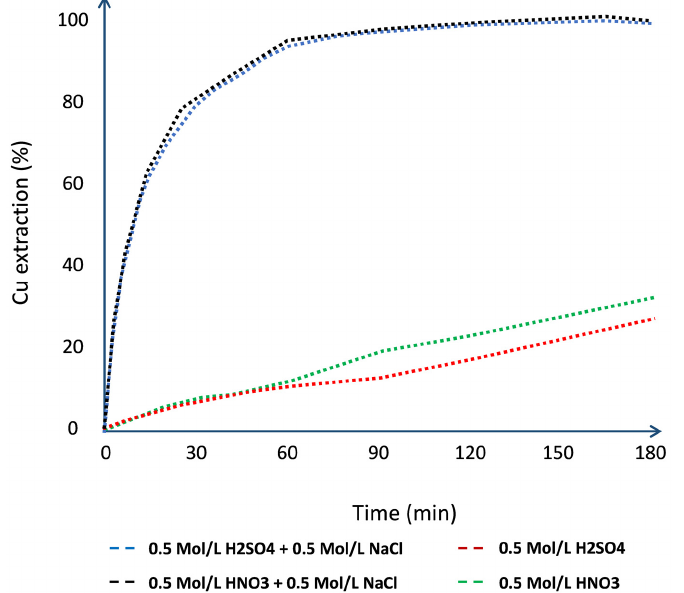
Figure 3. Effect of chloride ions on the acid leaching of chalcocite (T = 85 °C, particle size 31 µm) (Modified from: [24]).